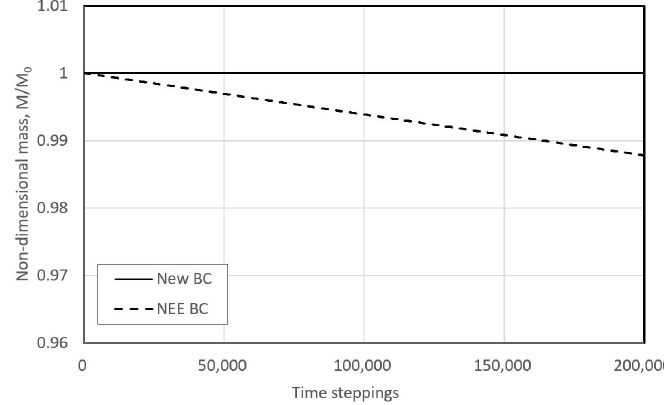
Figure 17. Variation of non-dimensional mass against time steps using the newly developed mass-conserved and NEE boundary conditions for a square